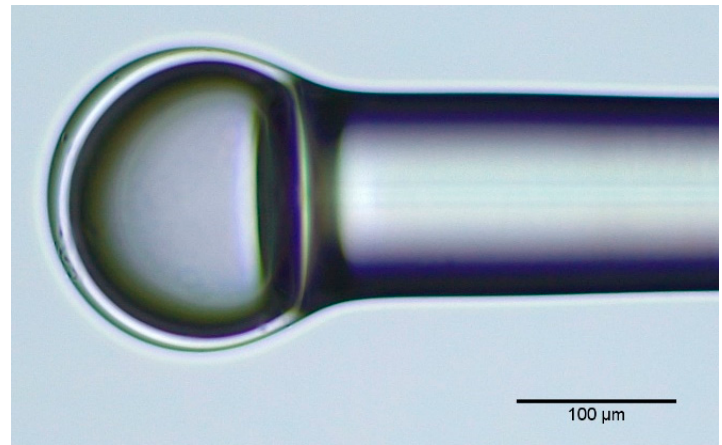
Figure 2. Microscope image of the fabricated hollow microsphere.